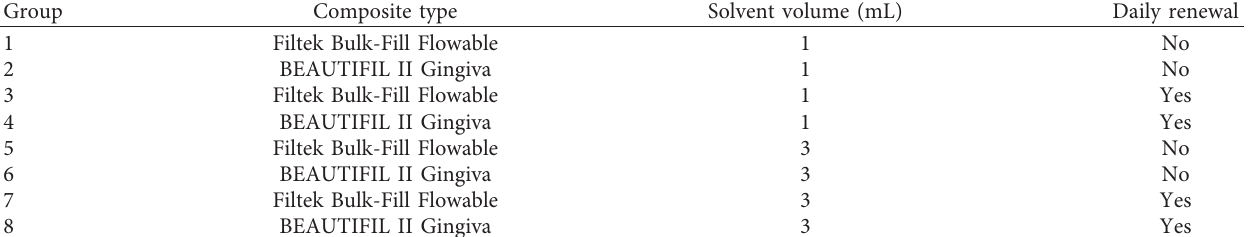
Table 2: Test groups.